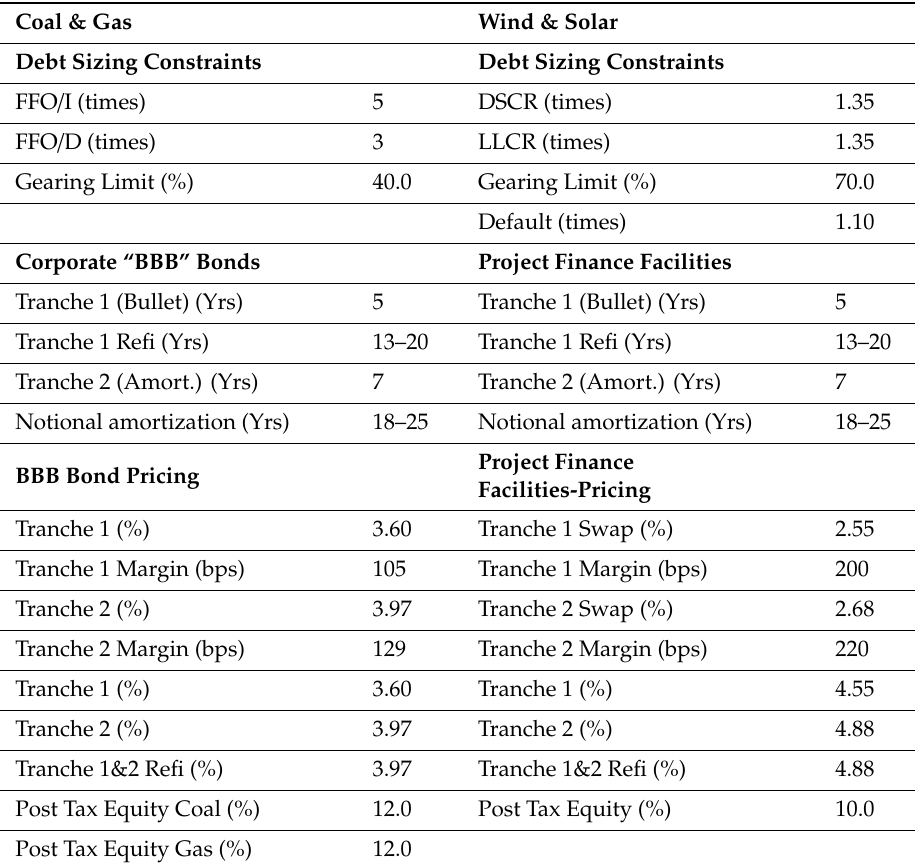
Table A1. Corporate Finance